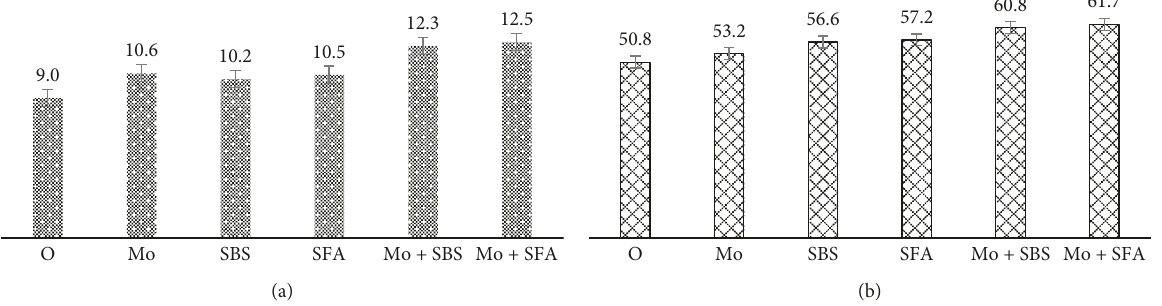
Figure 3: The influence of Mo and S application on the (a) phosphorus uptake (kg · P · ha − 1 ) and (b) potassium uptake (kg · K · ha − 1 ) (mean for 2012–2014).